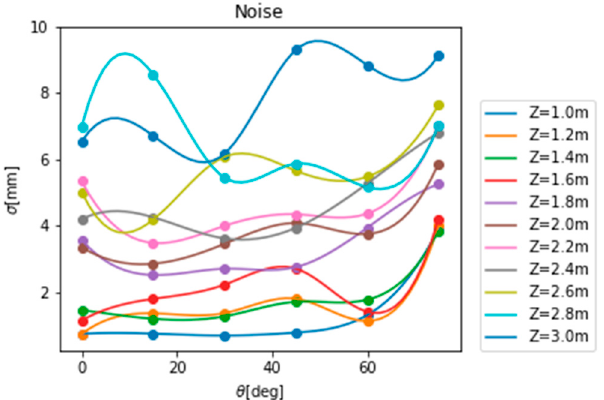
Figure 8. Kinect V1.0 indoor noise model.